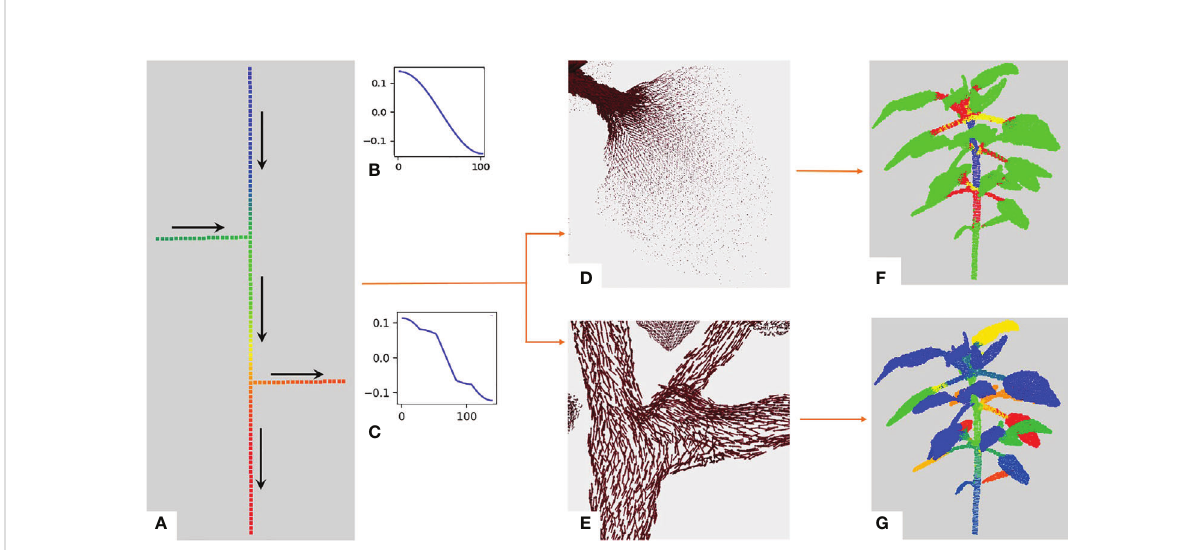
FIGURE 3 Illustration of the behavior of the Fiedler eigenvector on a toy example. (A) Simple example: a linear graph with two side branches. The vertical axis is composed of a hundred nodes chained together. The two remaining branches contain 20 nodes each chained together and connected to a node of the main chain through the fi rst node in their chain. The overall structure makes up a tree of node chains. We computed the Fiedler eigenvector on this graph and its values are shown with a rainbow color scale (red = highest values, blue = lowest values). Arrows indicate the directions of increasing values for the Fiedler eigenvector. (B) Values of the Fiedler eigenvector for each node from the bottom to the top of the graph in a) without the two side branches. (C) Values of the Fiedler eigenvector on the whole graph in (A) with side branches. Slope breaks correspond to extremal nodes or nodes connecting several branches. With the Fiedler eigenvector, we obtain the Fiedler ADG vector fi eld. (D) The norm of the vectors drops between the petiole and the leaf blade. (E) Unit vectors of the Fiedler ADG vector fi eld are displayed, demonstrating that the directions of the vectors follow the axes of the plant. (F) K -means clustering obtained using the norm of the Fiedler ADG vector fi eld, with K =4 . 2 − and 3 − dimensional shapes (leaves and apices) are in green while linear shapes are divided into red, yellow and blue. (G) Instance segmentation obtained at the end of the fi rst stage of our algorithm. Each instance is in a different